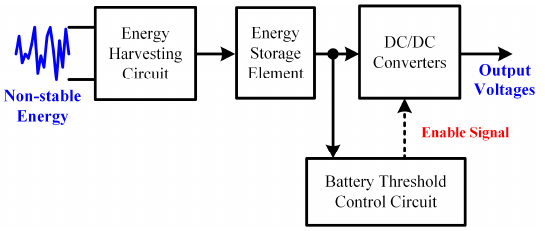
Figure 4. The functional block diagram of power module.